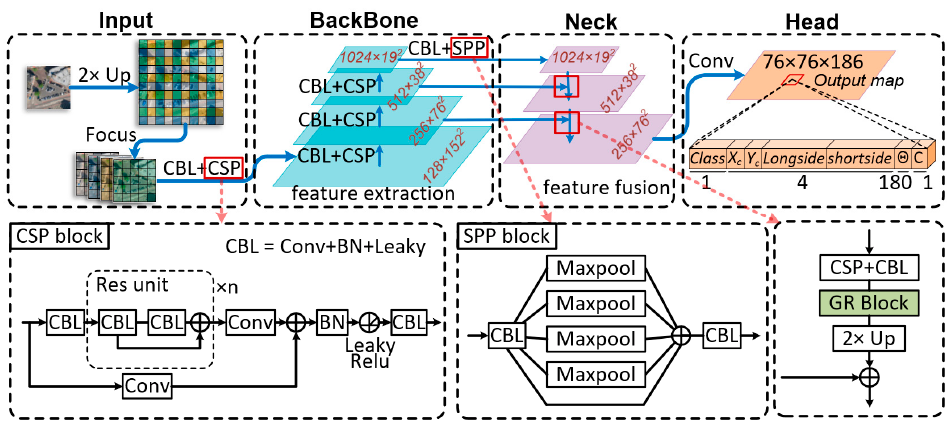
Figure 4. Overall architecture of the SSRD-Net framework.